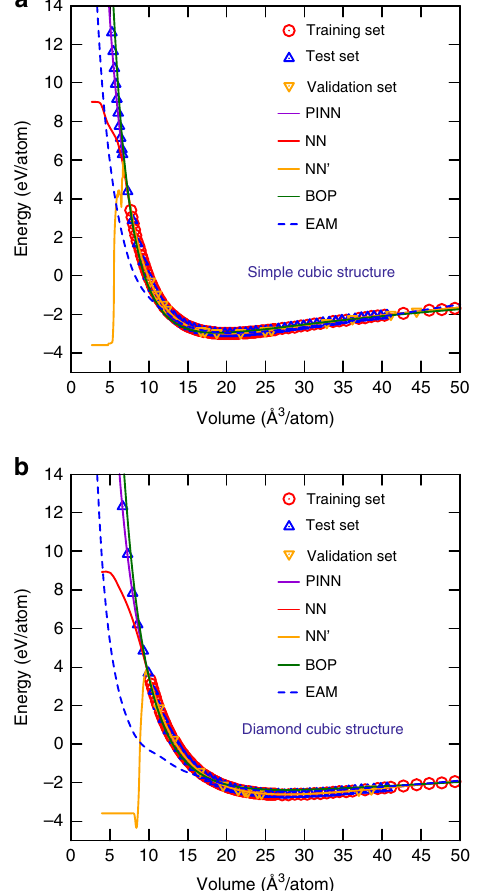
Fig. 6 Zoom into the repulsive part of the energy – volume relations predicted by the PINN, NN, NN ′ , EAM, and BOP potentials (curves) and DFT calculations